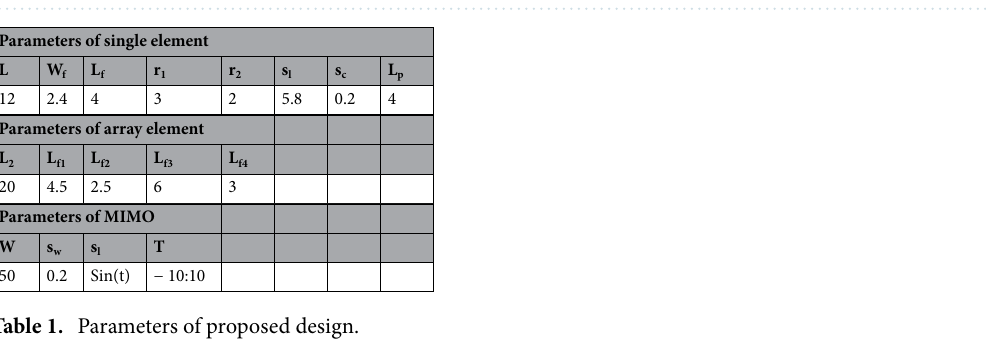
Table 1. Parameters of proposed